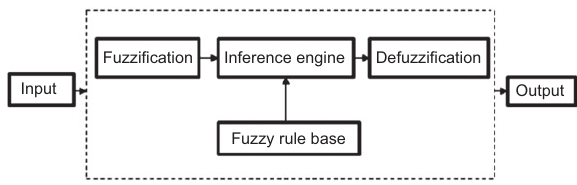
Figure 1 Basic elements of FL [38]